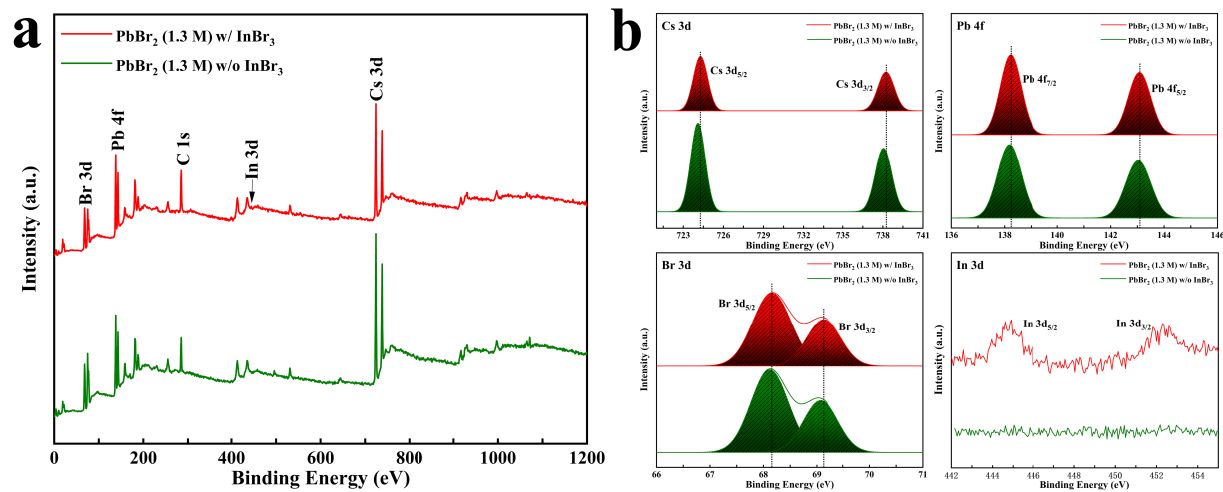
Figure 5. ( a ) XPS spectra and ( b ) Cs 3d, Pb 4f, Br 3d, and In 3d core spectra of the InBr 3 :CsPbBr 3 synthesized with the PbBr 2 concentration of 1.3 M.